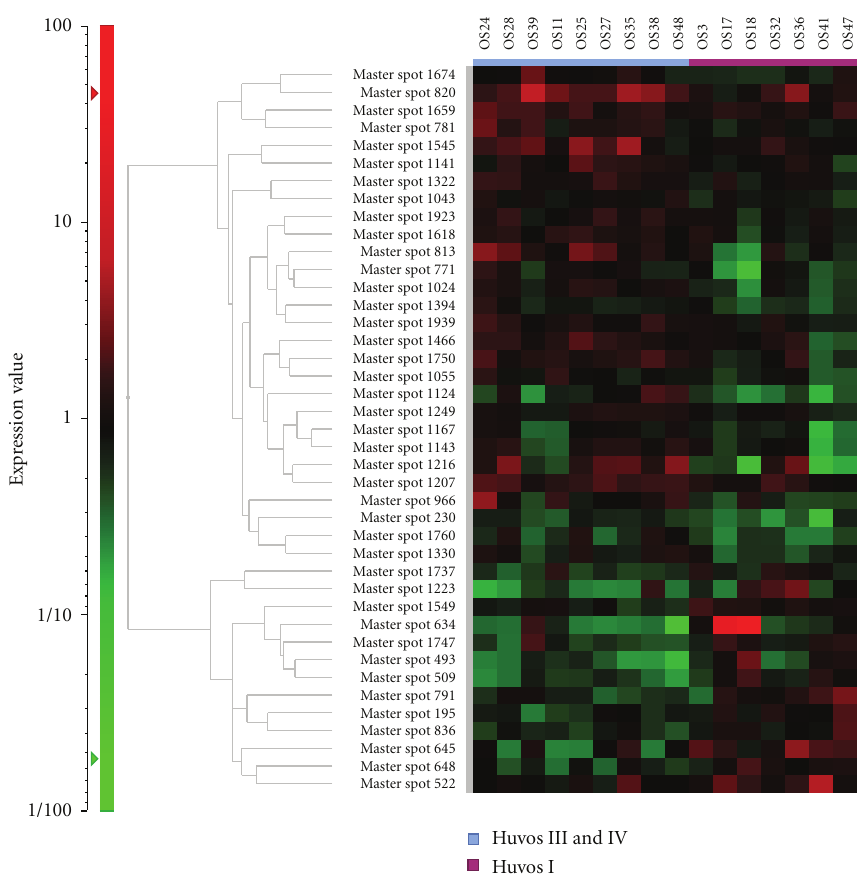
Figure 2: To identify proteins associated with the chemosensitivity of osteosarcoma, we conducted a 2D-DIGE study using osteosarcoma biopsy samples. A hierarchical cluster analysis of 16 osteosarcoma samples demonstrated that there were 41 protein spots that had di ff erent levels of intensity between samples. These 41 protein spots were identified from a total of 1465 protein spots ( P < 0 . 05). The expected value of this study (from 1465 total protein spots and P < 0 . 05) was > 73 protein spots. Therefore, the study design could not acquire a su ffi cient number of protein spots that had statistically significant di ff erences in the expression levels between